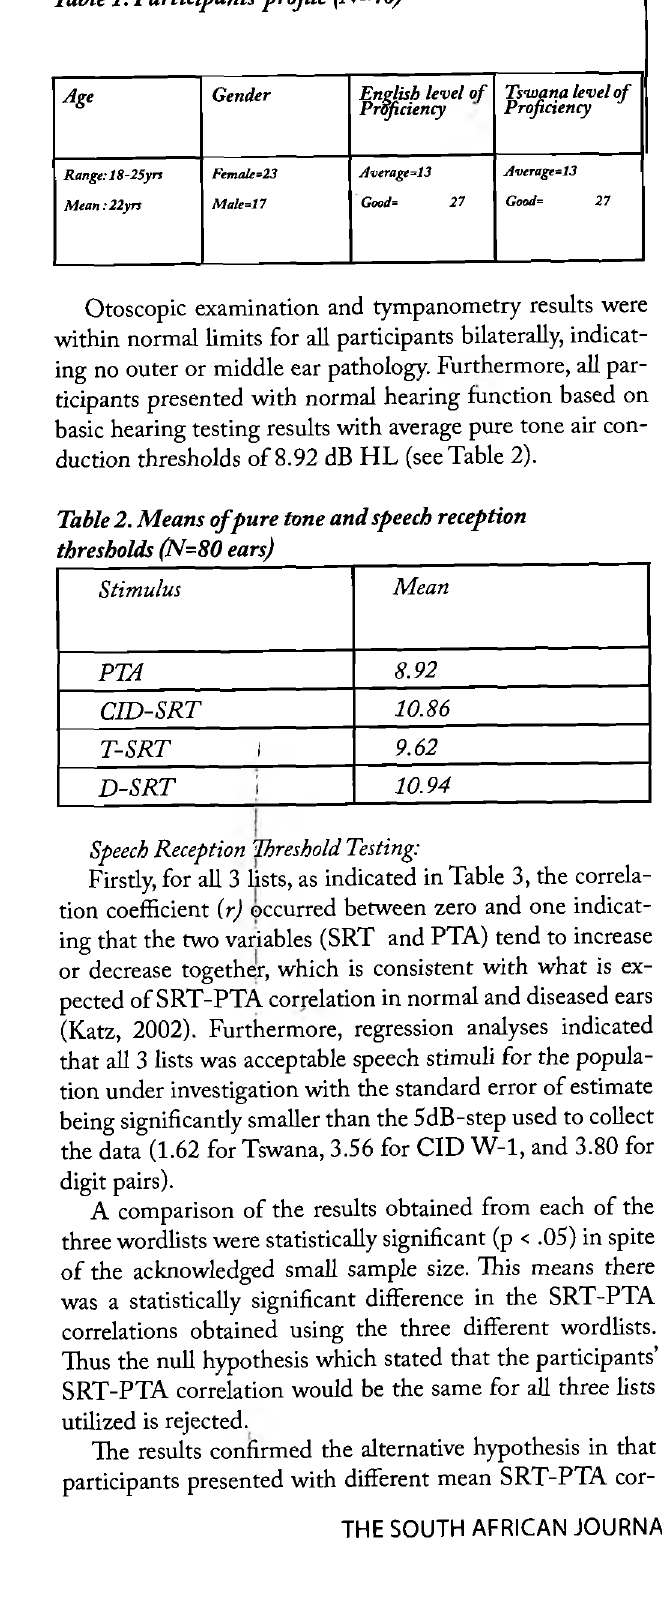
Table 1. Participants’profile (N=40)